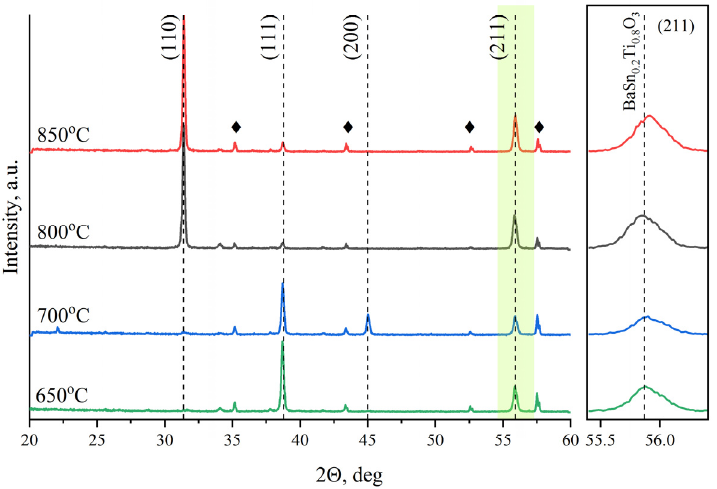
Figure 3. Diffractograms of the BTS thin films on Al 2 O 3 substrates at different substrate temperatures after annealing at 1100°C in air.